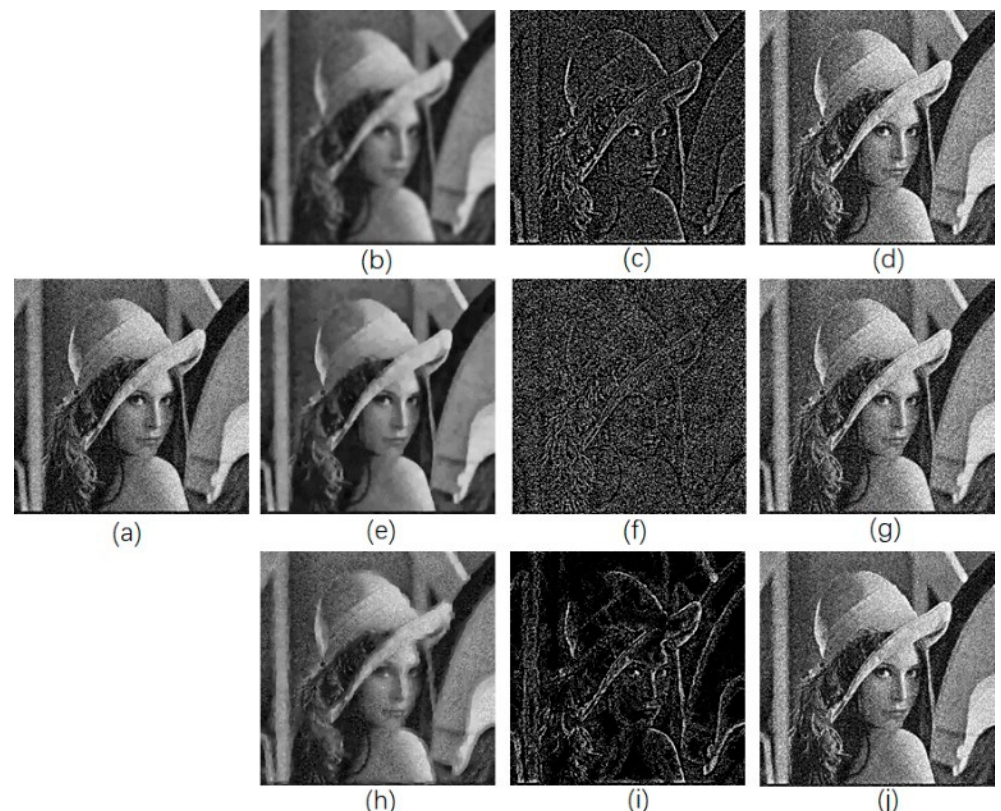
Figure 2. Image enhancement by use of di ff erent model. ( a ) Original image; ( b ) image smoothed by Gaussian kernel; ( c ) unsharp mask by subtracting ( b ) from ( a ); ( d ) enhanced image by adding ( c ) with ( a ); ( e ) smoothed image by use of traditional anisotropic di ff usion; ( f ) Unsharp mask; ( g ) enhanced image; ( h ) smoothed image by use of reversed anisotropic di ff usion; ( i ) Unsharp mask; ( j ) enhanced image.